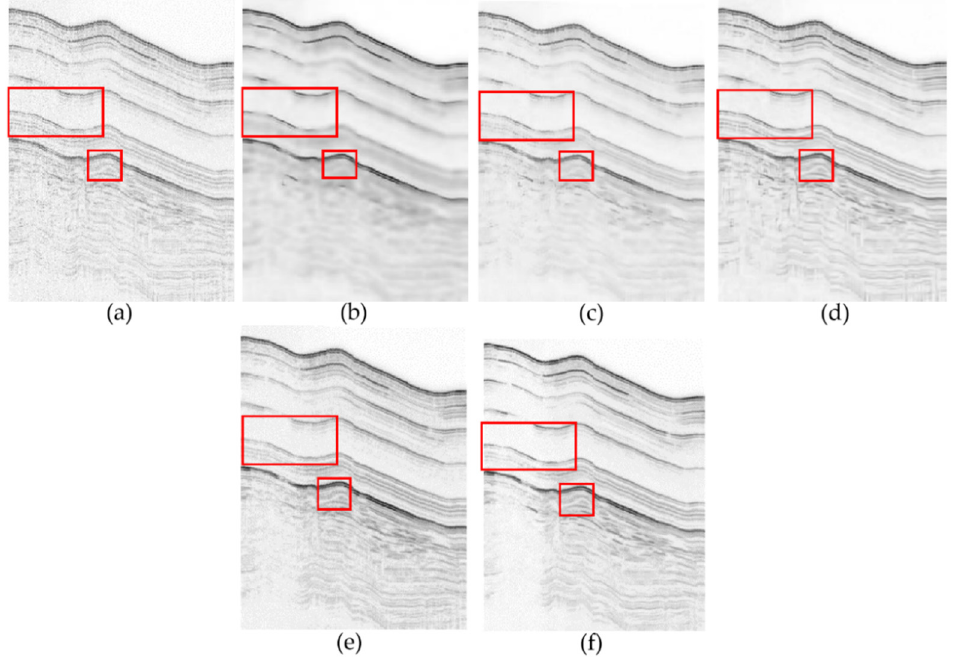
Figure 9. Filtering results: ( a ) is the SBP image after grayscale equalization, ( b – f ) are the filtered results using KSVD, Non-local Means (NLM), Block-Matching and three-dimensional (3D) filtering (BM3D), the conventional non-local low-rank filtering method (NLLR), and the proposed method.